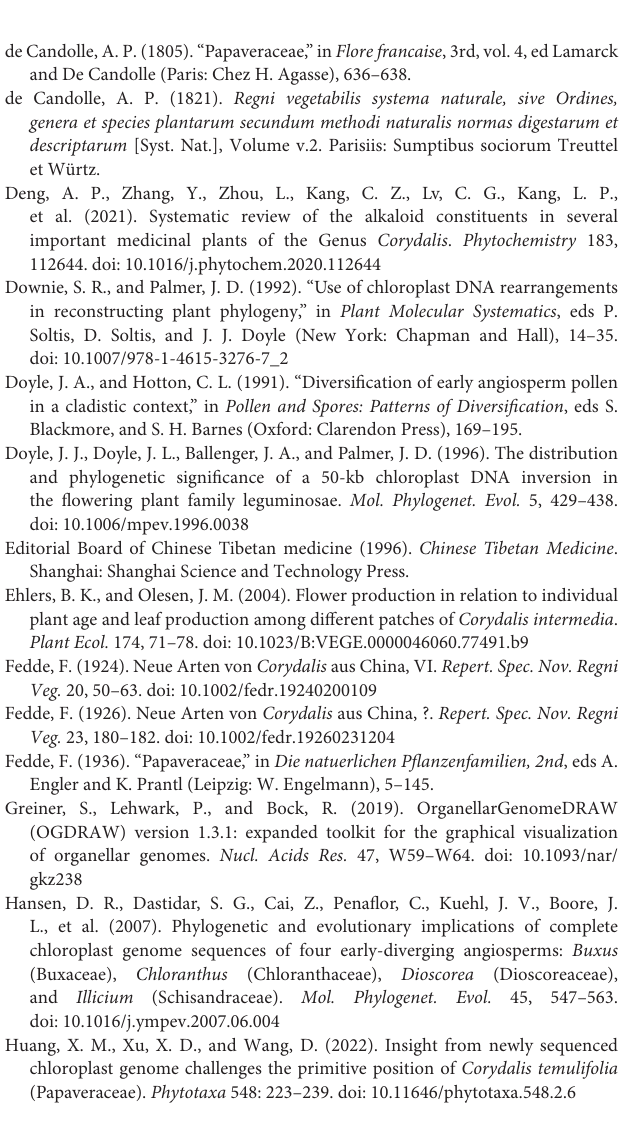
“-1,” “-2,” and “-3,” indicate the nucleotide that corresponds to the first, second, or third positions of the codon, respectively.